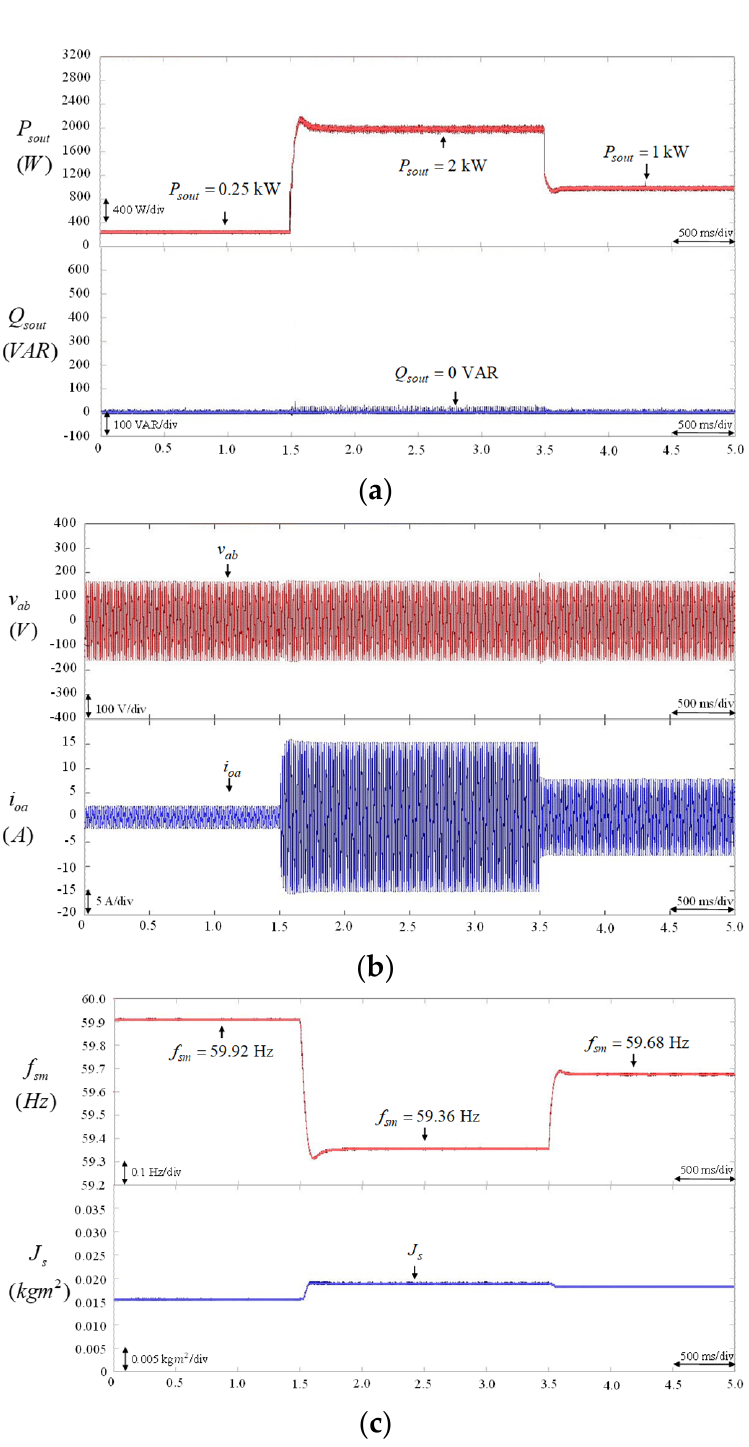
Figure 10. FNN-controlled BESS using proposed virtual inertia estimator. ( a ) Responses of real power output P and reactive power output Q of BESS; ( b ) responses of line-to-line voltage v output current i oa of BESS; ( c ) responses of virtual rotor frequency f sm of VSG control and estimated virtual inertia J s